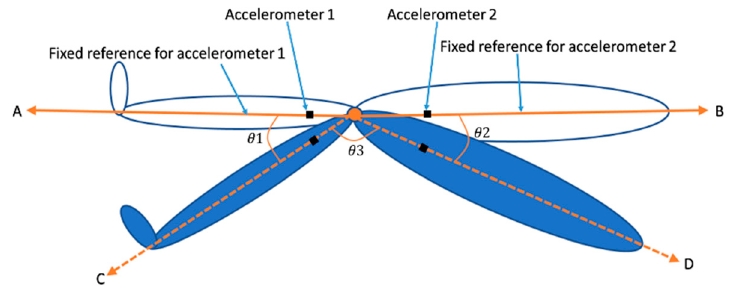
Figure 6. Diagram to show joint bending angle between an upper and lower limb.